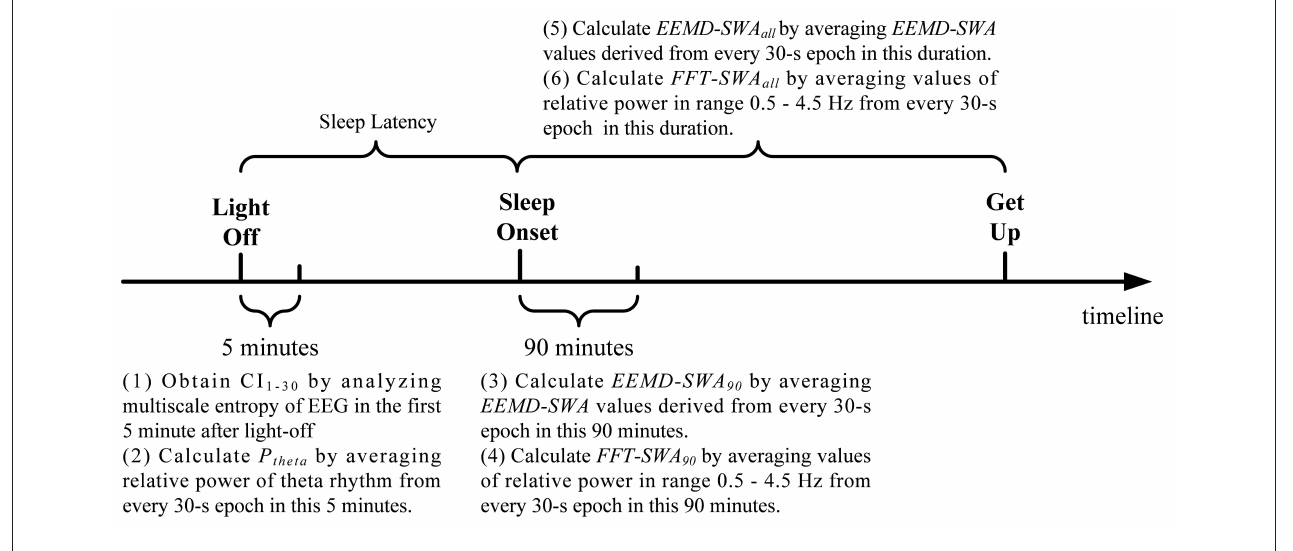
FIGURE 1 | Schematic diagram of the timeline regarding EEG